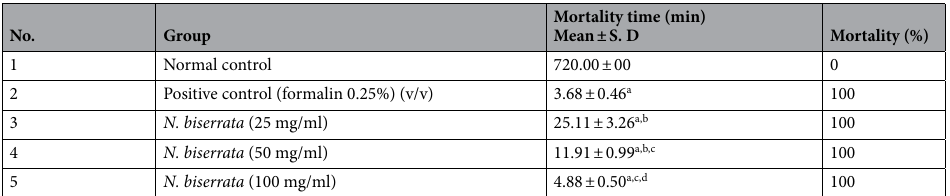
Table 1. Mortality time of the leeches at different concentrations of methanol extract of N. biserrata. Each value represents the mean ± S.D of 6 parasitic leeches per group. a Significance at p < 0.05 compared with the normal control group. b Significance at p < 0.05 compared with the formalin treated group (0.25% v/v). c Significance at p < 0.05 compared with N. biserrata (25 mg/ml). d Significance at p < 0.05 compared with N. biserrata (50 mg/ml).